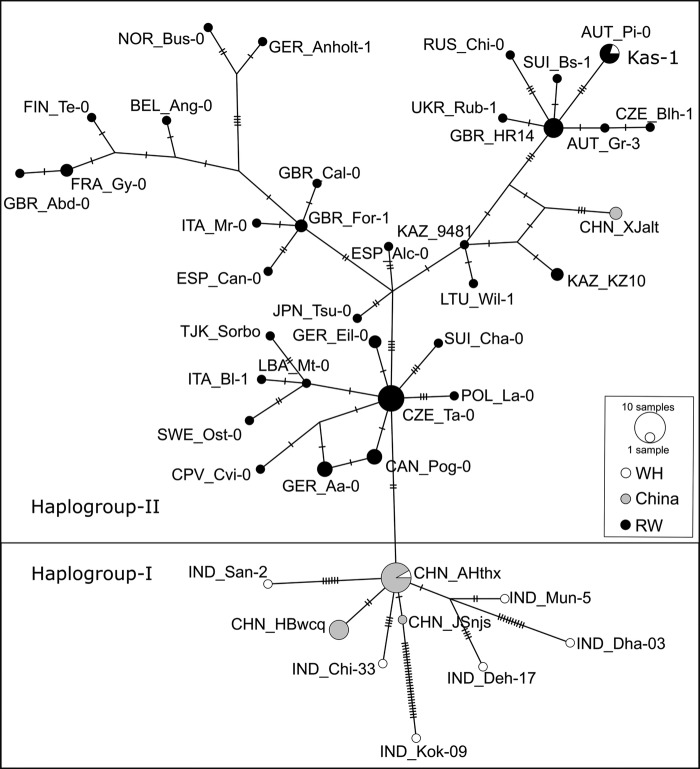
Haplotype network. There were a total of 46 haplotypes from 83 accessions from combined data set of A. thaliana accessions as inferred using concatenated sequences of 11 CP markers. The Haplogroup I contains the accessions from west Himalaya and Yangtze region, and the Haplogroup II contains the accessions from the rest of the world. Individual discs indicate haplotypes with the size of the disc proportional to the number of accessions in the haplotype [see
Supporting Information—Table S6]. Hatch marks denote nucleotide changes.